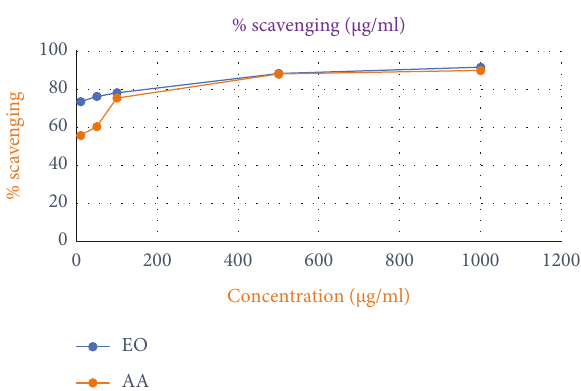
Figure 4: Free radical scavenging activity of EO from S . gigas stem bark and standard (ascorbic acid).